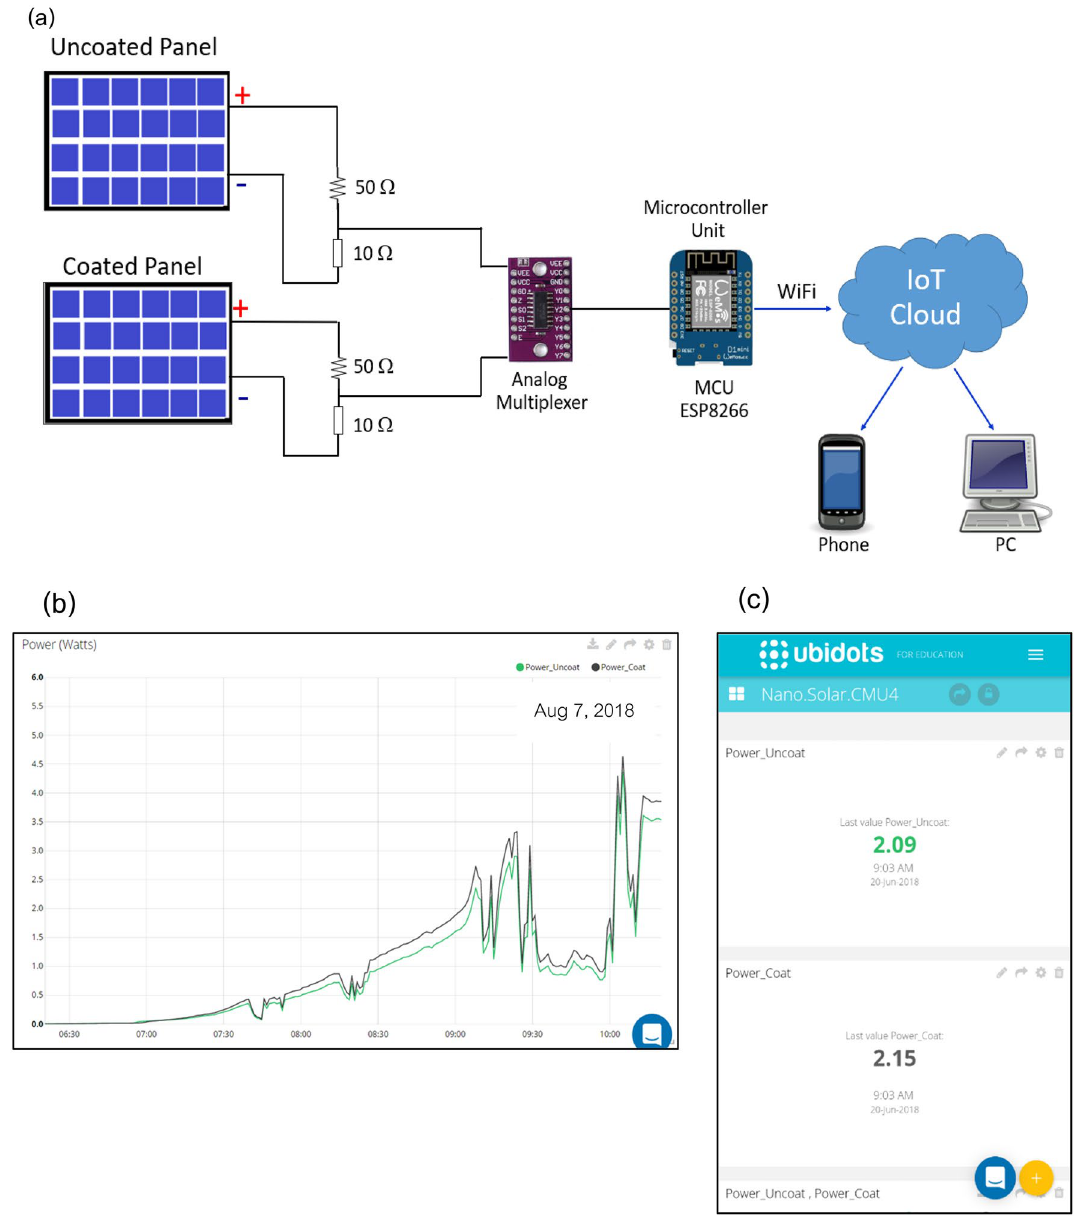
Figure 3. ( a ) Experimental set-up of the panels ( b ) screenshot of Ubidots website ( c ) power generated monitored via Ubidots Explorer